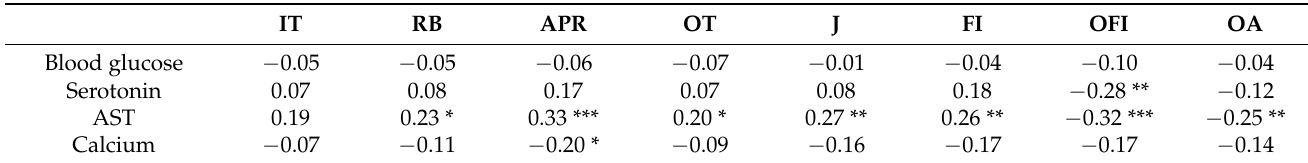
Table 4. Correlation coefficients between the serum biochemical parameters and sensory quality traits of broilers.